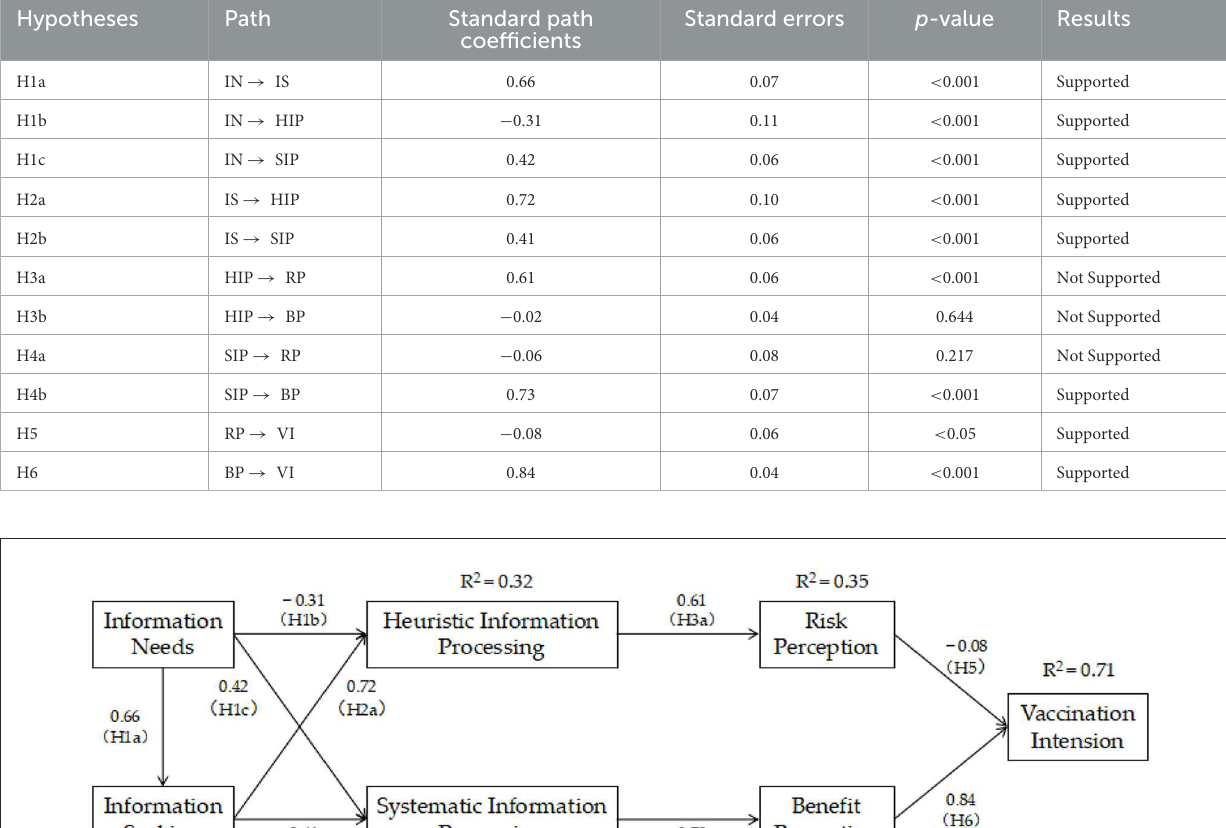
TABLE 5 The results of path coefficient.